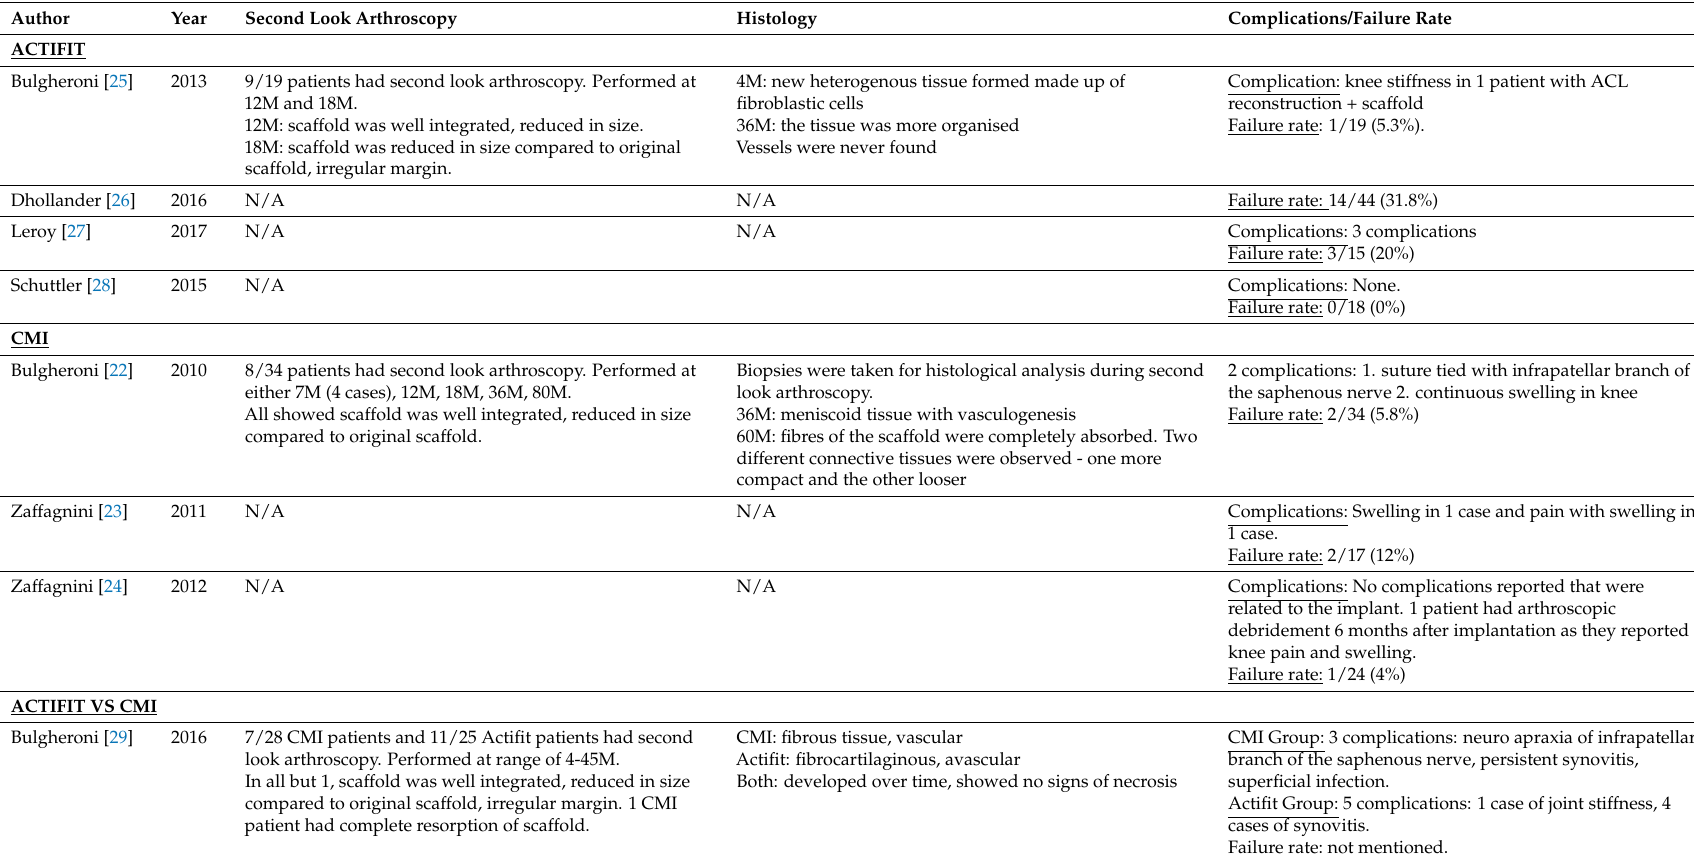
Table 4. The second-look arthroscopy and histological findings along with complications and failure rate of each